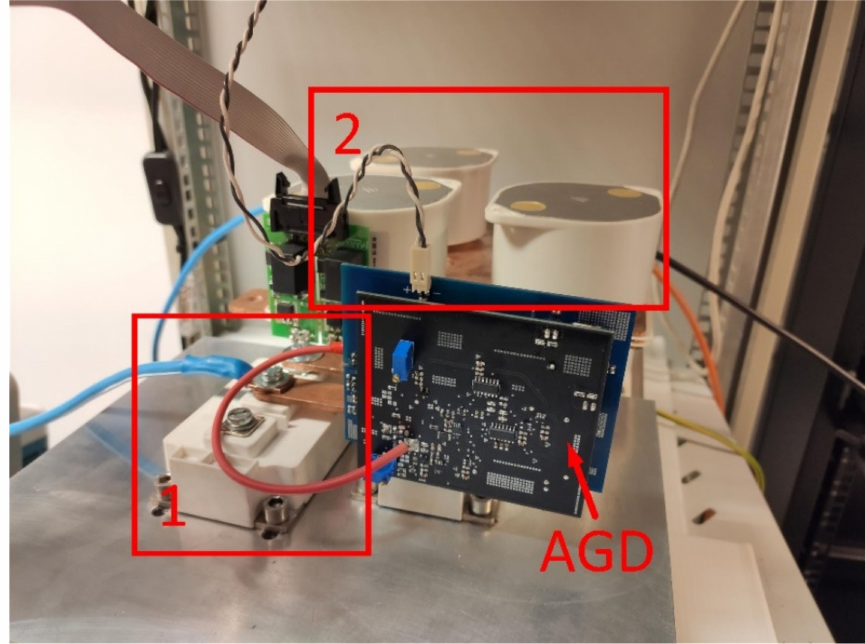
Figure 9. Photo of the experimental setup. 1—CAS300M17BM2 module, 2—DC bus and blocking